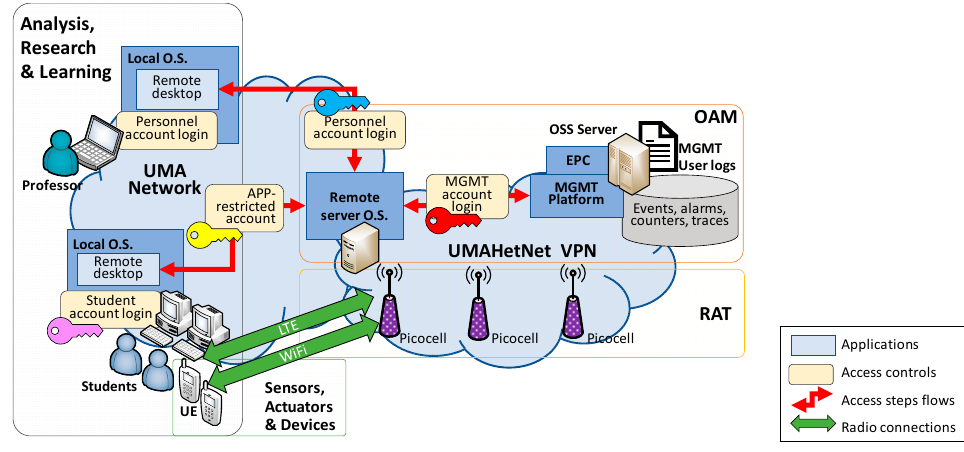
Figure 8. UMAHetNet learning access scheme.